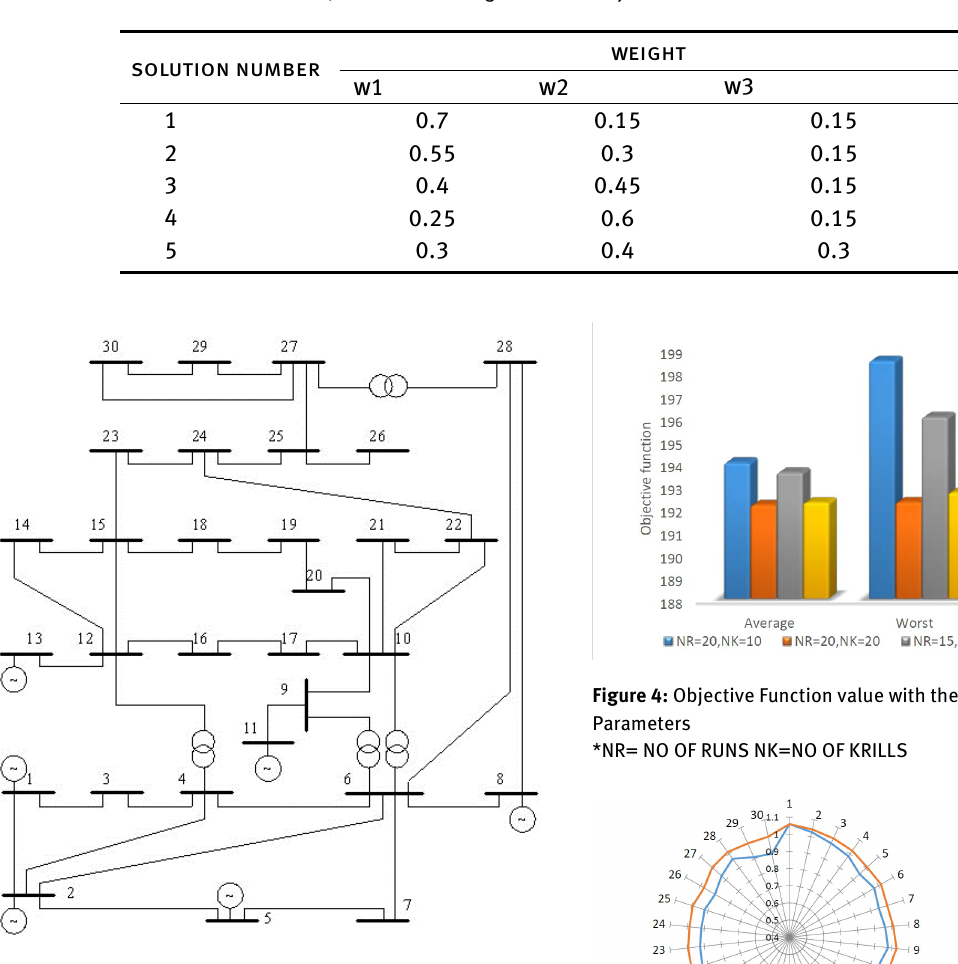
Figure 2: Typical IEEE 30 bus system